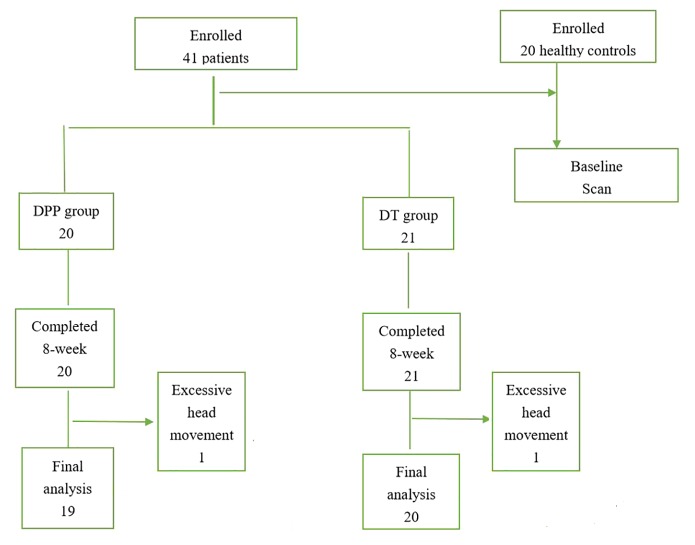
The consort flow diagram for the present study.